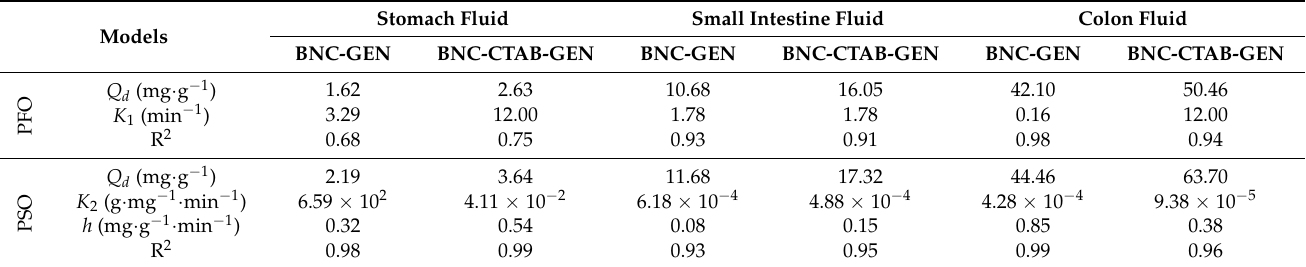
Table 4. Release kinetics models.